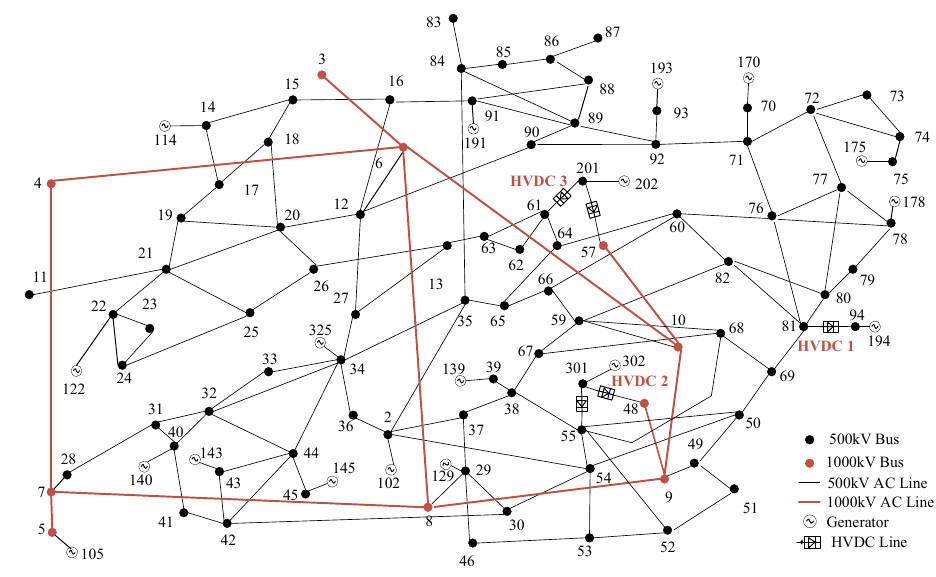
Figure 5. Topology of test system 1.